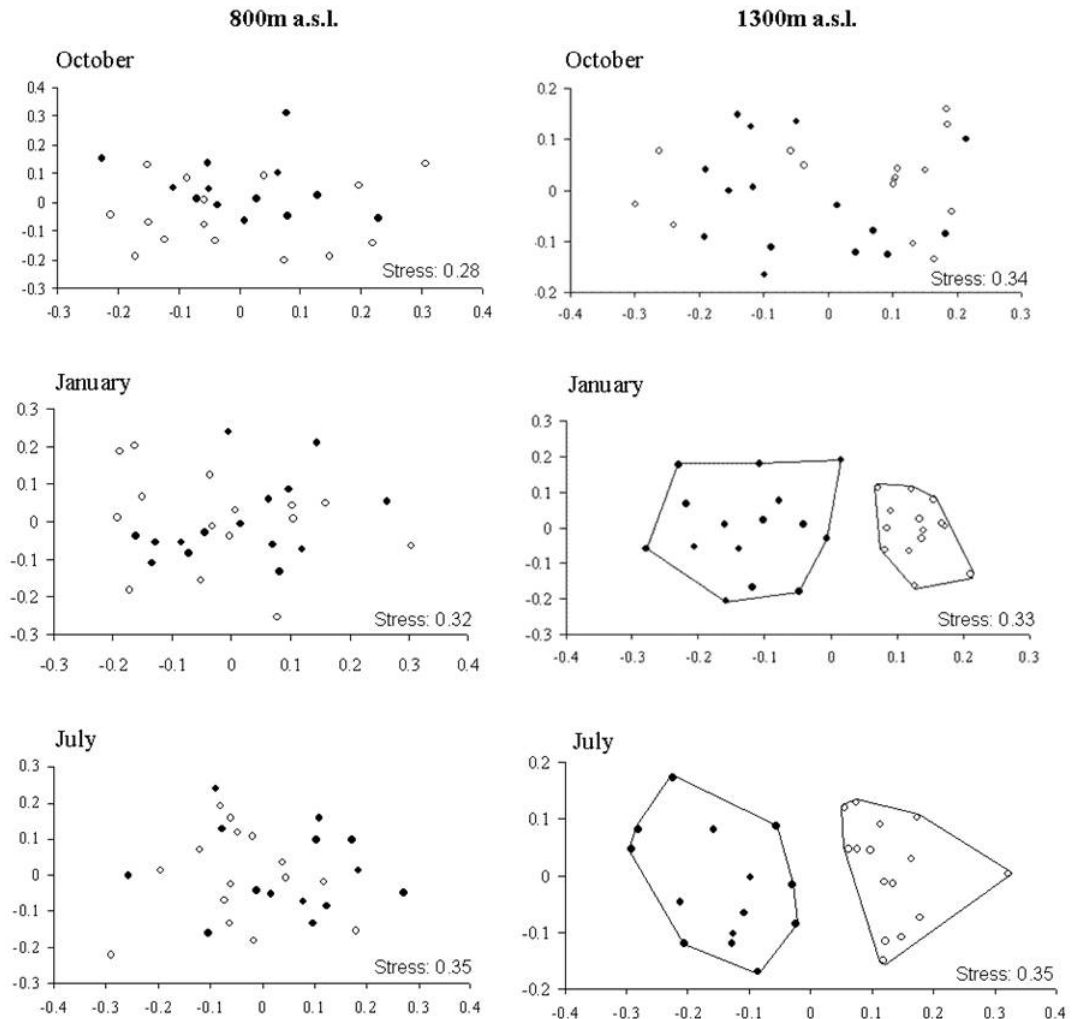
Fig 3 . Ant species spatial distribution in Non Metric Dimensional Scale (NMDS) in campos rupestres at two altitudes (800 and 1300 m); filled symbols correspond to burned plots. The polygons represent significant differences between the plots (P